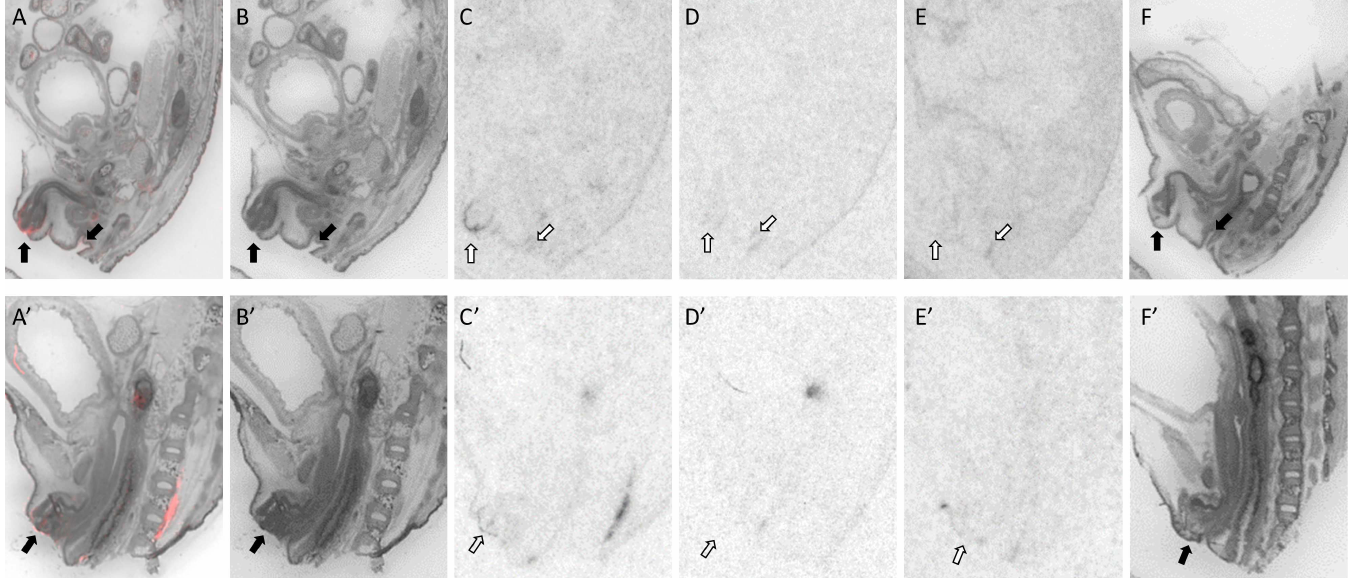
Fig 6. OXTR ligand binding in the anogenital region of P0 mice. A male is depictedin A-F, a female in A’-F’. Pseudo-color composite (OXTR in red, cresyl violet counterstain in gray) (A, A’), followedby cresyl violet counterstain (B, B’), with black arrows indicatingregionof interest. OXTR ligandbindingis indicatedby white arrows in the 0 nM OXT competition(C, C’), followedby 1000 nM OXT competingwith OVTA radioligand to reducethe signal (D, D’). Specific bindingcan be observedin the female mouse (C’), with part of the spinal cord (caudaequina)displayingrobust signal (not quantified) that diminishes with increasing OXT competition(D’). Nonspecificbindingcan be seen more central to the image in female mouse as well, on a part of the upper colon. OXTR ligandbindingwas not present in OXTR KO mice (E, E’), followedby the post-processed cresyl violet tissue of the OXTR KO (F,